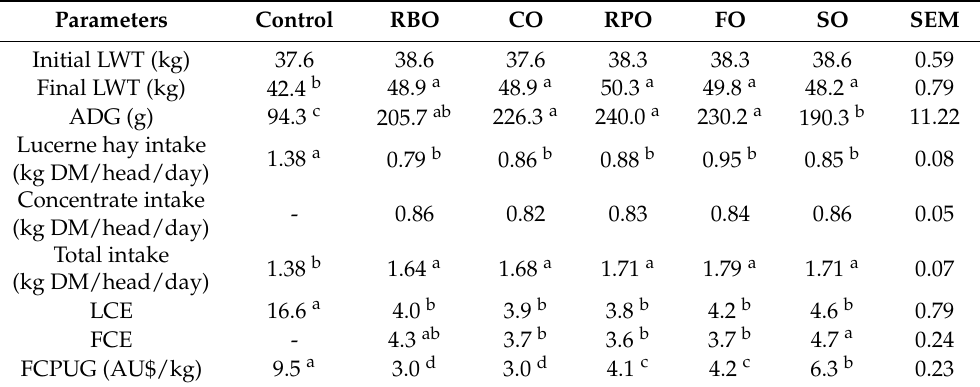
Table 2. Liveweight, average daily gain, feed intake and feed costs per unit gain of prime lambs fed various PUFA enriched pellets *.